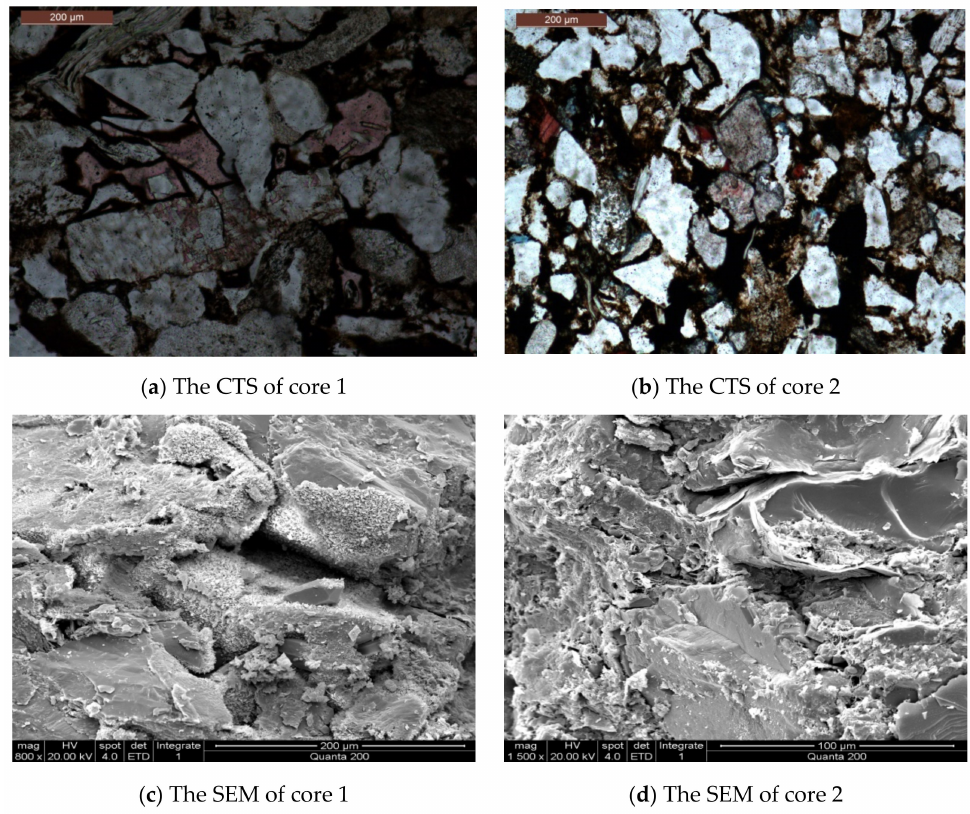
Figure 2. The CTS and SEM of cores.